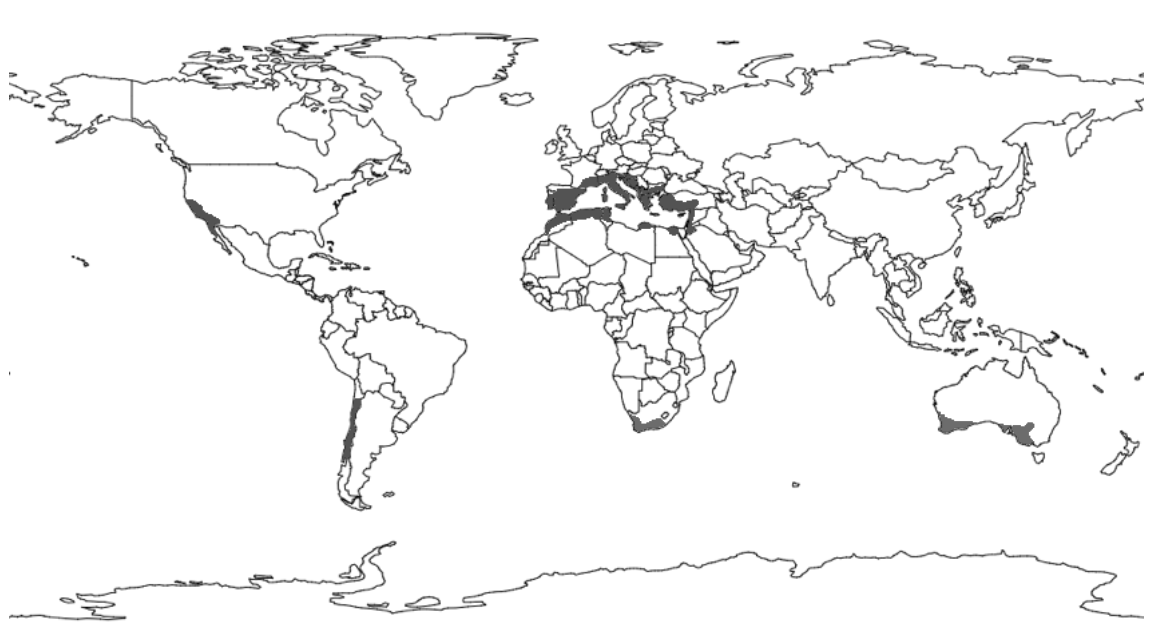
Figure 2. Location of the Mediterranean-type climate regions, which are distributed by Central Chile, California and Northern Baja California, Southwest and South Australia, Western Cape, South Africa, and the Mediterranean basin.